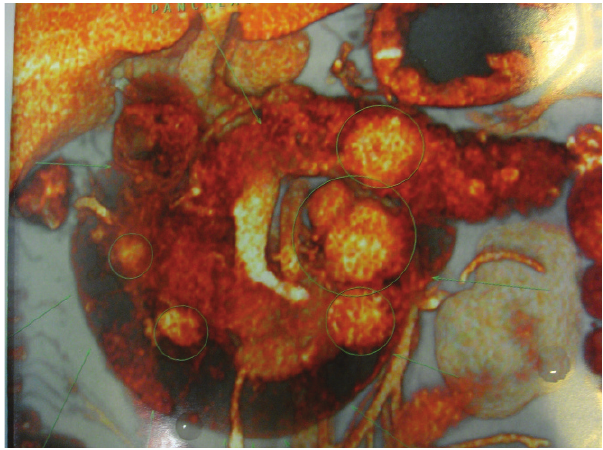
Figure 2 - Octroscan showing gastrinomas disseminated through- out the pancreas. Total pancreatectomy was performed in this case.